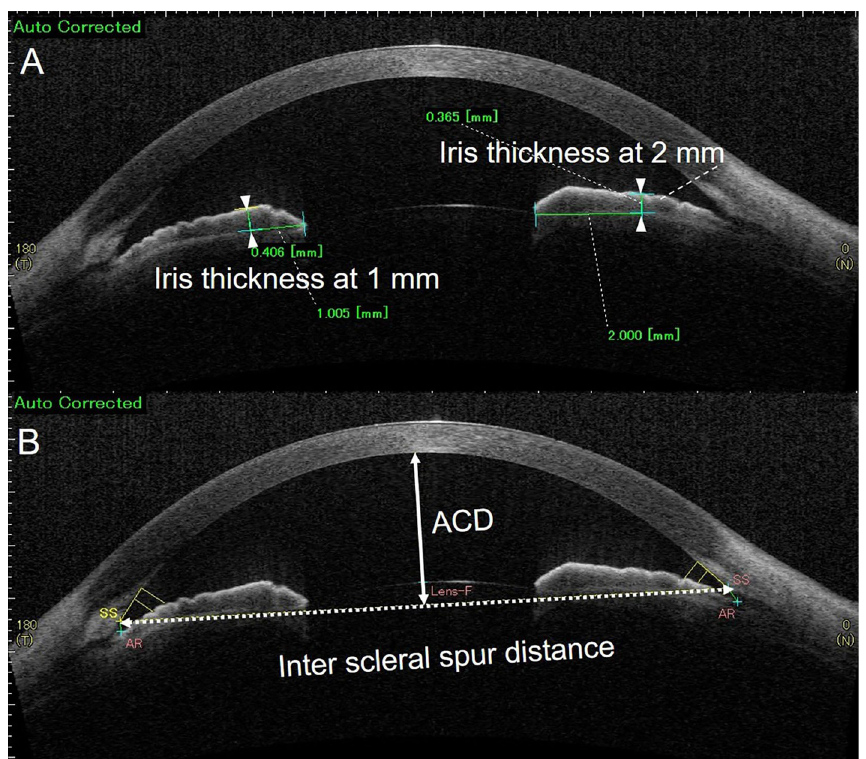
Fig 1. Morphological parameters of the iris and anterior chamber measured using swept-source anterior-segment optical coherence tomography. A. IT (iris thickness) measured at 1 and 2 mm from both the temporal and nasal angles. B. ACD (anterior chamber depth) refers to the vertical width of the anterior chamber. Inter-scleral spur distance (SS distance) refers to the horizontal width of the anterior